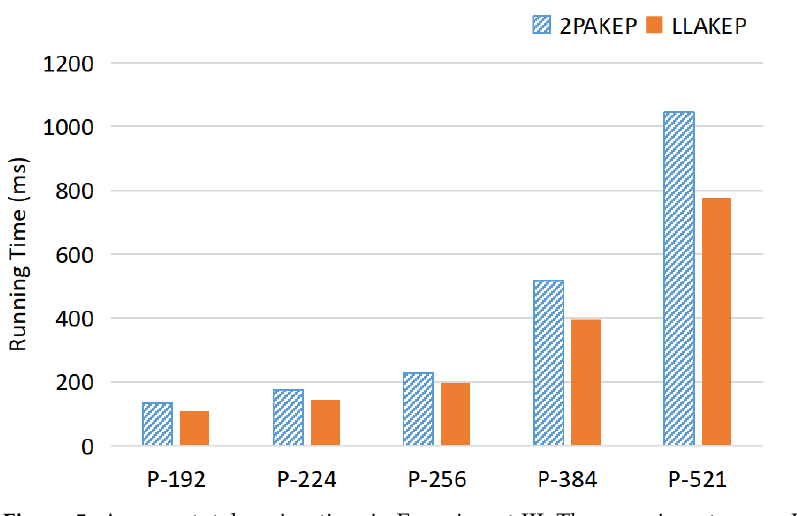
Figure 5. Average total runing time in Experiment III. The experiment uses a Raspberry Pi and a laptop to measure the total running time of LLAKEP. The results show that LLAKEP has shorter total running time compared with